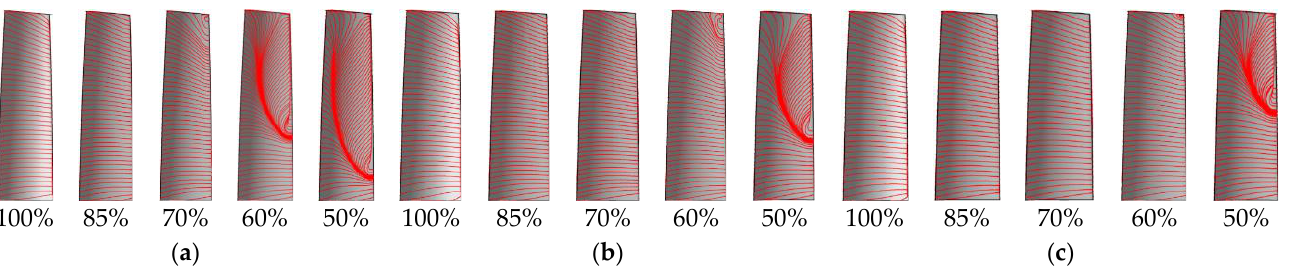
Figure 7. Limiting streamlines on the M-P surface at different loads (3.4 MPa back pressure): ( a ) Last stage blade; ( b ) penultimate stage blade; ( c ) antepenult stage blade.